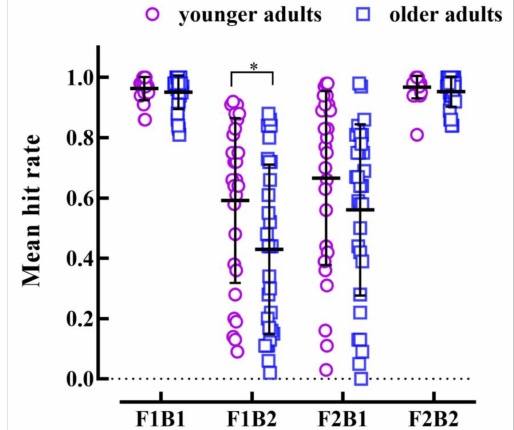
Figure 2. Mean hit rate of each participant in four conditions. F1B1 indicates the condition in which a flash is accompanied by a beep, F1B2 indicates the condition in which a flash is accompanied by two beeps, and the mean hit rate of F1B2 is significantly lower than that of F1B1, which produces the fission illusion. F2B2 indicates that two flashes are accompanied by two beeps at the same time; and F2B1 indicates the condition in which two flashes are accompanied by a beep. The mean hit rate of F2B1 is significantly lower than that of F2F2, which produces the fusion illusion. Short cross lines represent the mean hit rate, and error bars represent standard errors, * indicates p < 0.05.